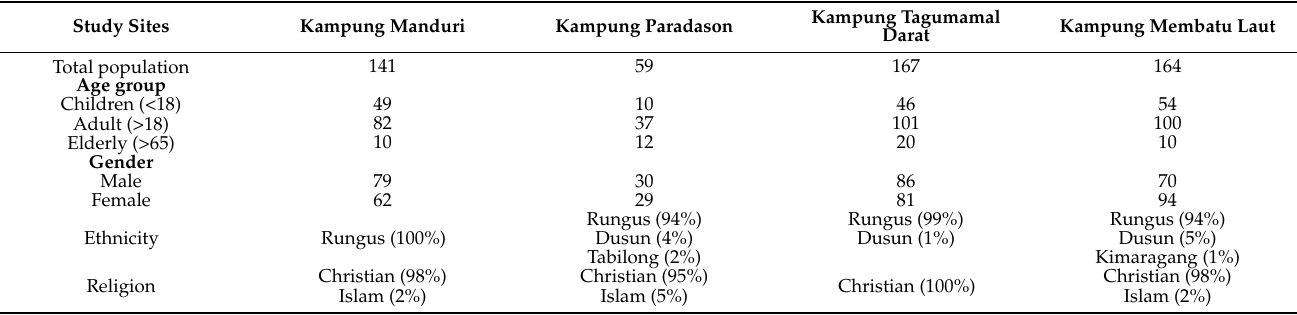
Table 2. Characteristics of the study